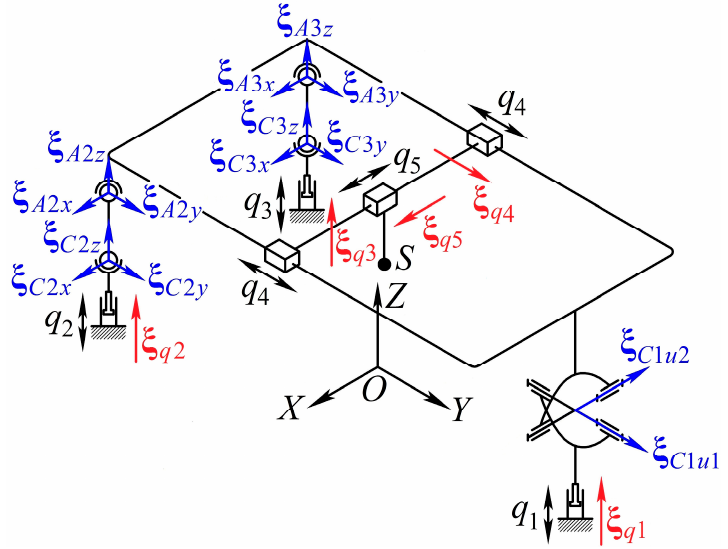
Figure 3. Joint (unit) twists of the manipulator. Blue arrows designate zero-pitch twists; red arrows designate infinite-pitch twists.